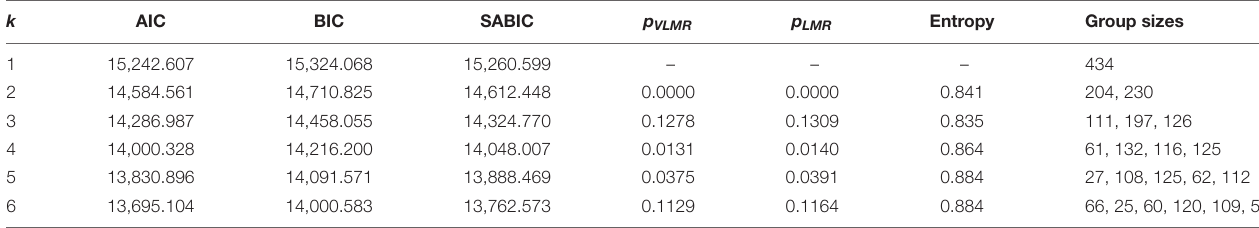
TABLE 2 | Fit indices for latent profile